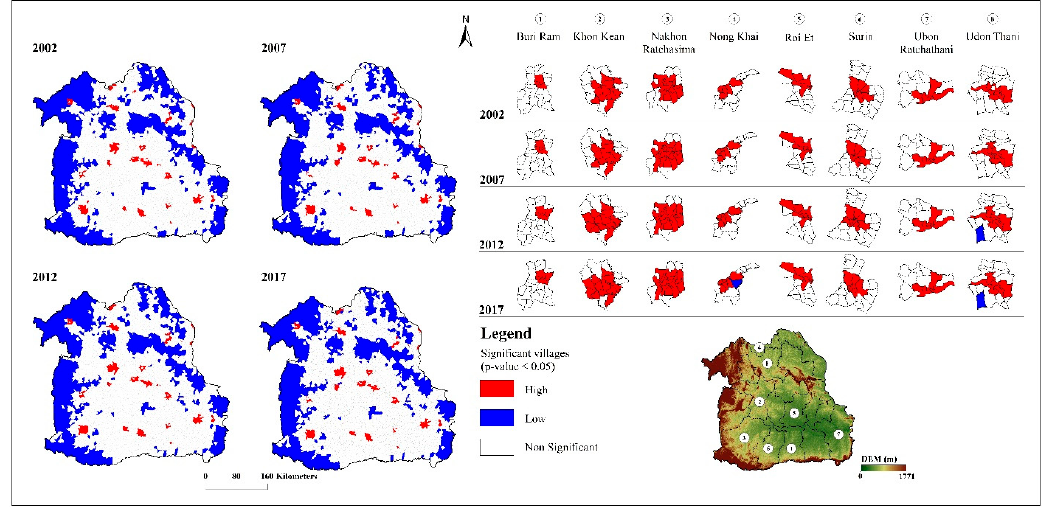
Figure 4 . Local spatial autocorrelation ( Getis–Ord G i *) of the Northeast during 2002–2017.